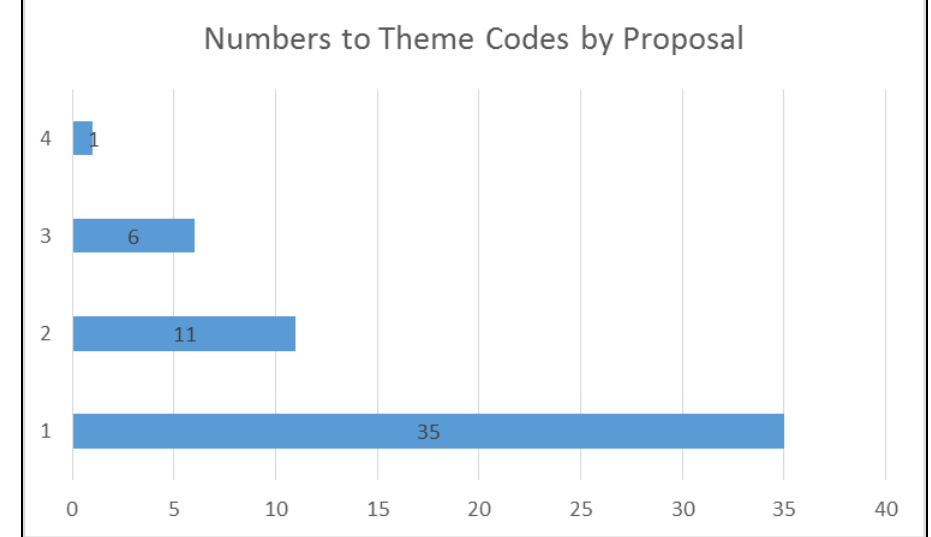
Figure 8. Numbers to theme codes by proposal.